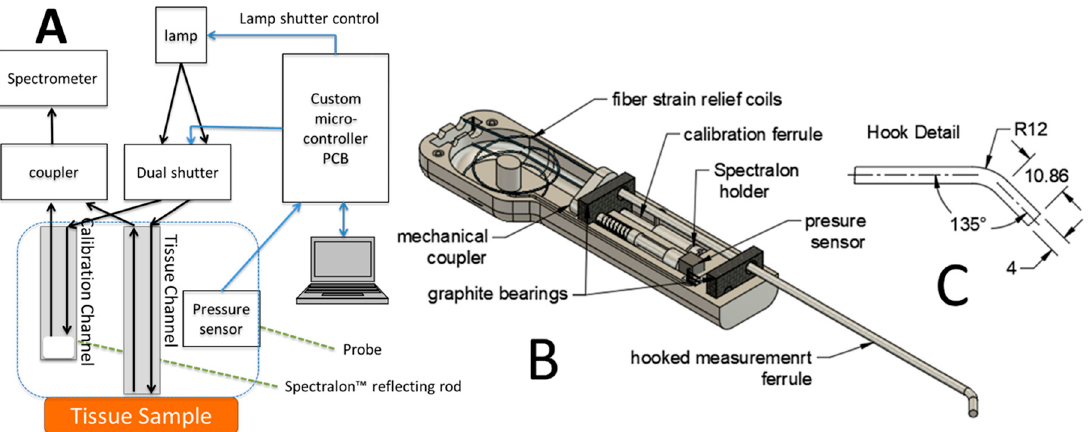
Figure 1. An instrument schematic shows the system components. ( A ) The instrument includes an optical switch (dual shutter) to direct light to either a calibration or tissue-sensing channel for automated calibration measurement. ( B ) The probe handle (internals exposed) features a pressure-sensing system that uses a spring-loaded metal ferrule that contacts a force sensor. The probe ferrules were uncoupled from the weight of the cable through use of a coiled segment of bare cable that can flex as the fiber tip is pressed against the sample. ( C ) An engineering drawing illustrating dimensions (mm) of the hooked sample ferrule. Straight ferrule not shown.